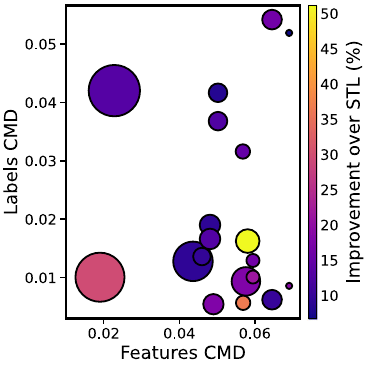
Fig. 4 Visualizing data distribution shift and dataset size with performance. Scatter plot of the average central moment discre- pancy (CMD) in label and feature space for each downstream task across the top- n (i.e., “ closest ” n ) extractors for n = 4. Other values of n were also explored without ostensibly different results. Marker sizes are scaled with the downstream dataset size and colored by MoE ’ s improvement on MAE over without yielding ostensibly signi fi cant differences. The size of each plotted data point indicates the size of the downstream task data, and the color indicates MoE ’ s improvement over STL on that task. Figure 4 reveals no discernable trends, highlighting the dif fi culty of predicting transferability with simple proxies. Instead, machine-learned models, like MoE, are needed to determine which source tasks are most useful for a downstream task. Plausible explanations for the lack of emergent patterns are (1) uncertainty in the improvement over STL obfuscates any trends, (2) 19 downstream tasks is too small of a sample size, (3) CMD is not the optimal distance metric for capturing divergences in task distributions, and (4) decoupling the domain and feature spaces X and Y catastrophically ignores the connection between structure and properties.